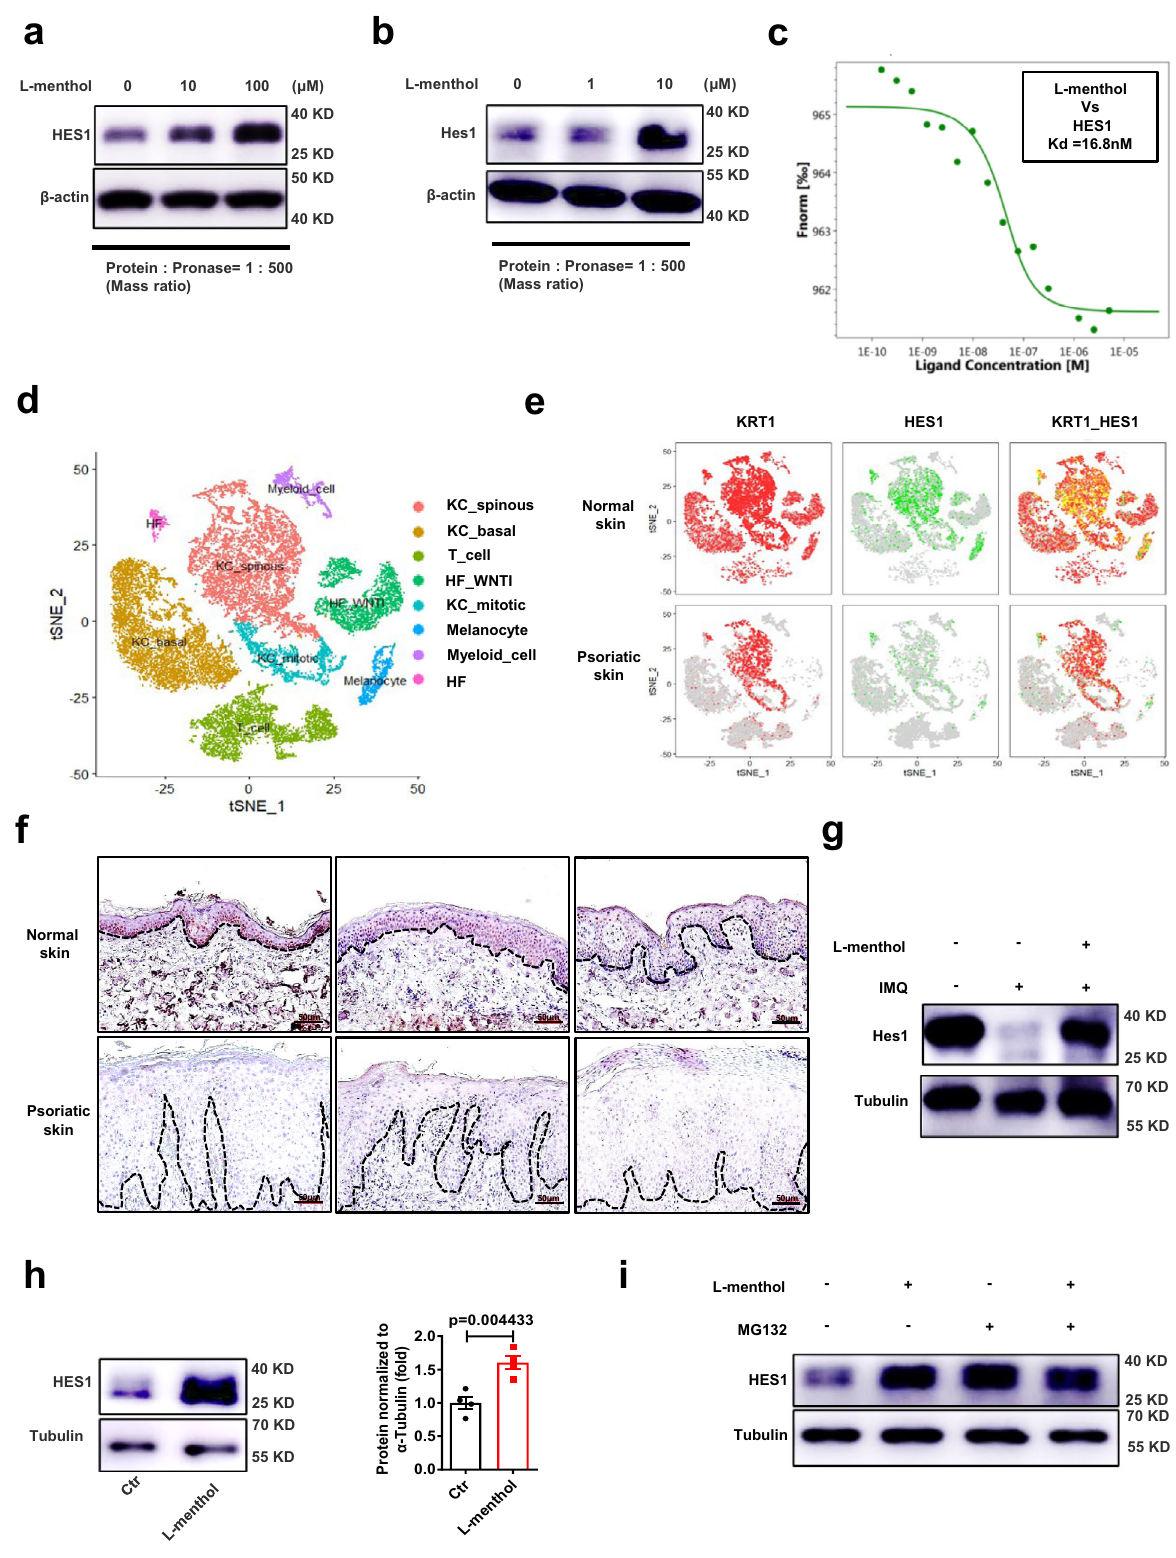
(Fig. 6e, f). Besides, L -menthol weakened the ubiquitination of PP6 which is consistent with the effect of IGBP1 overexpression in kerati- nocytes(SupplementaryFig.11c).Takentogether,IGBP1promotesPP6 expression in keratinocytes and inhibits its ubiquitination probably through disrupting the binding of CHIP.